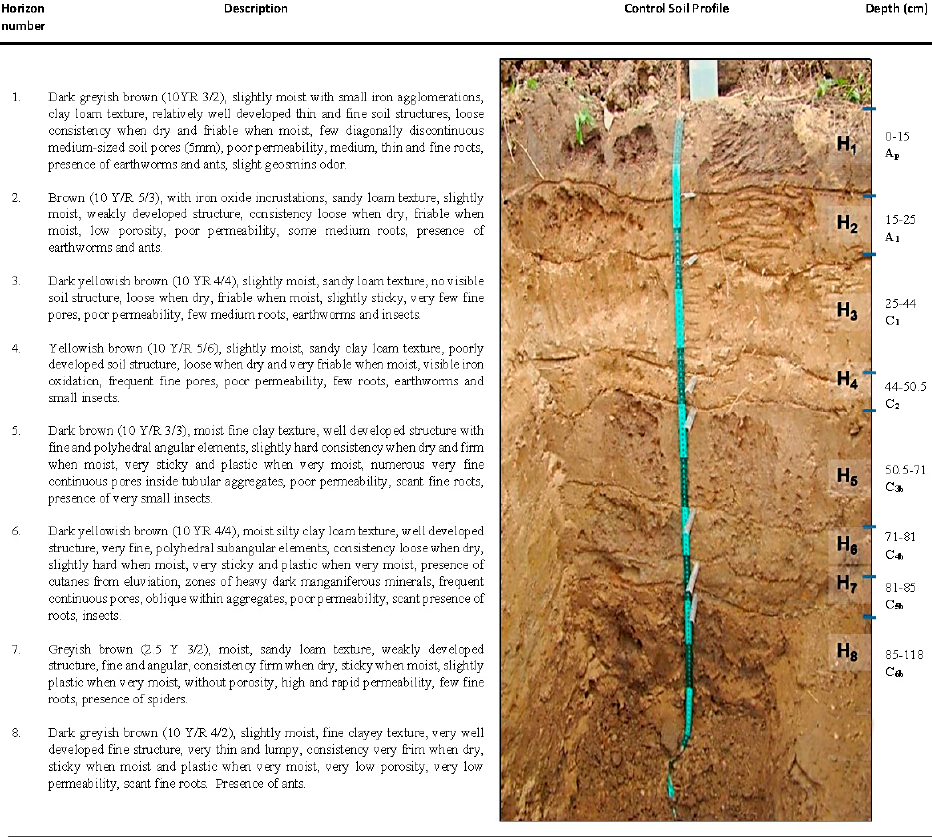
Figure 1. Control soil profile.